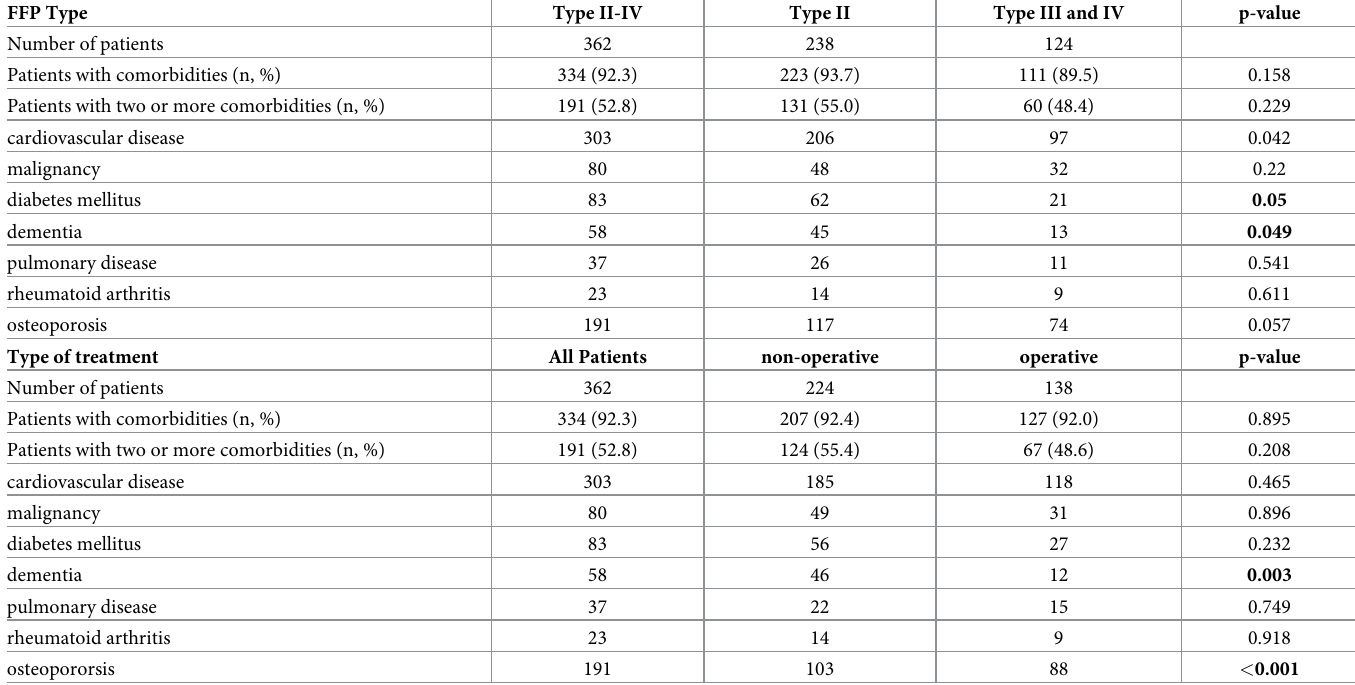
Table 3. Type and number of comorbidities in all patients, depending on FFP-classification and on type of